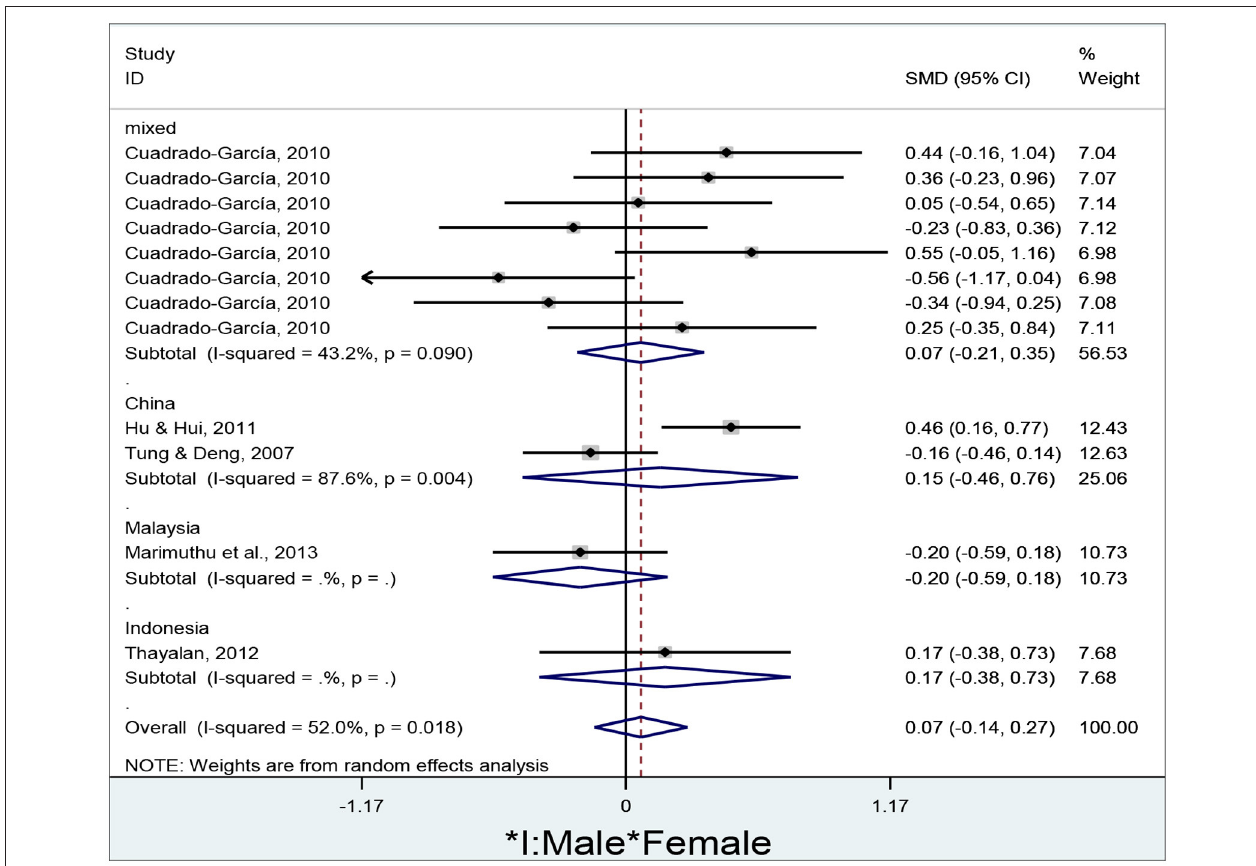
FIGURE 7 | Gender differences in e-learners’ motivation in different